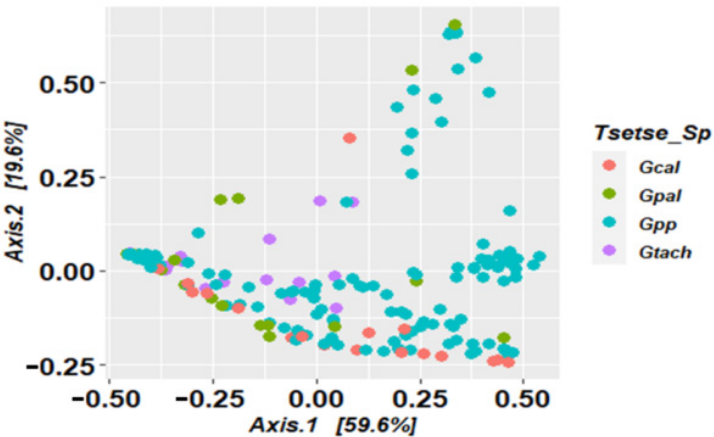
Figure 6. Distribution of the tsetse flies according to their microbiome composition, based on principal coordinates analysis using Bray–Curtis index (Gcal: G. caliginea ; Gpal: G. pallicera pallicera ; Gpp: G. palpalis palpalis ; Gtach: G. tachinoides ).